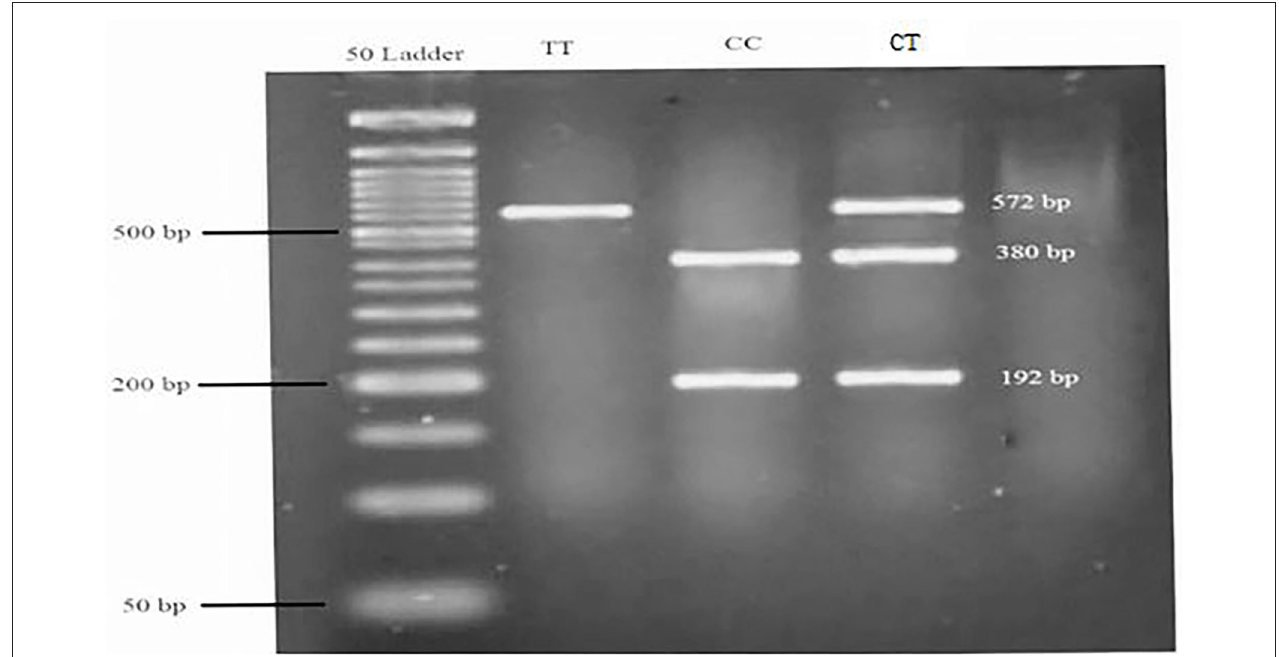
FIGURE 1 | Genotyping of the FADS2 rs174583 variant by TauI PCR-RFLP analysis. A 50-bp ladder was used to determine the length of the digested products. TT = homozygous mutated (572 bp), CC = homozygous wild-type (380 and 192 bp), CT = heterozygous mutated (572, 380, and 192 bp).